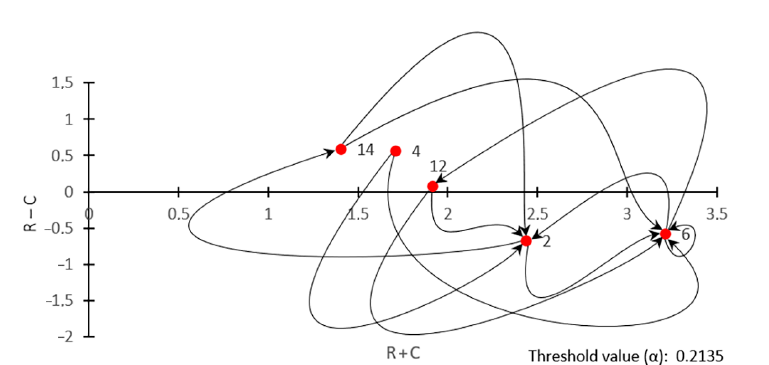
Figure 3. DEMATEL relationship diagram for C1 Physical